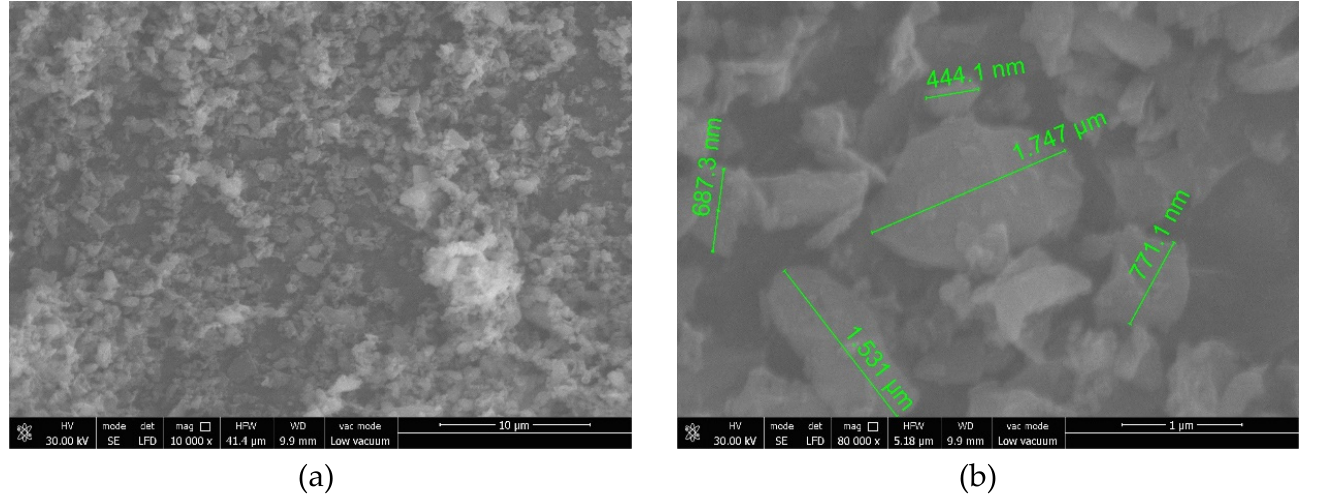
Figure 9. SEM images of SiC sample #1: ( a ) 10,000 times; ( b ) 80,000 times.